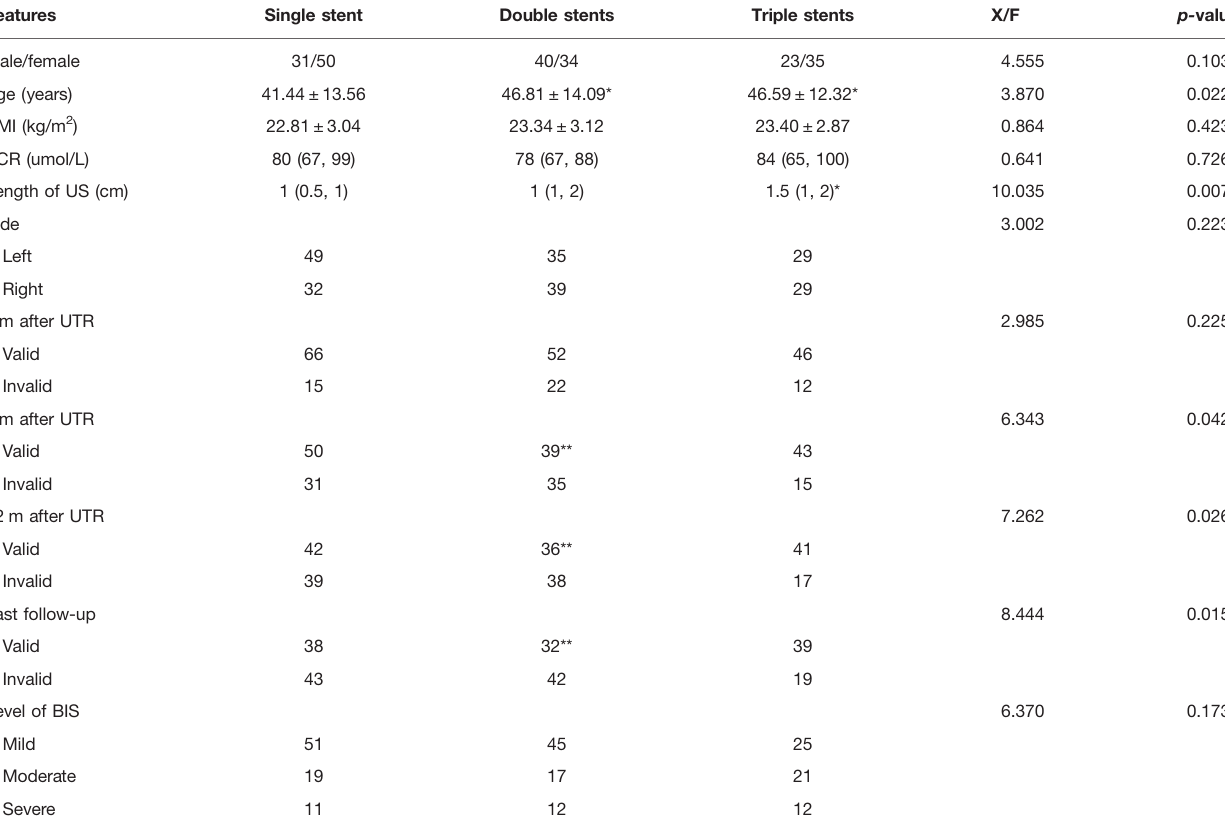
TABLE 1 | Baseline characteristics of enrolled patients in this